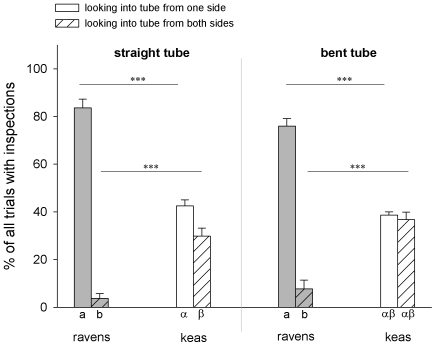
Frequency of looking into a tube from one side or both sides.Bars show mean and SE. Within-species differences between conditions are indicated by different letters below bars. Roman letters (a,b) refer to comparisons within ravens and greek letters (α,β) refer to comparisons within keas. Bars marked with different letters differ significantly (post-hoc Holm-Sidak analysis).